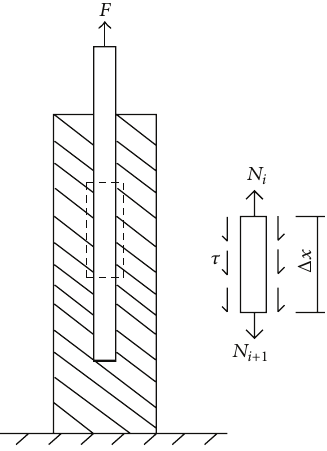
Figure 2: Interfacial mechanics model between bolts and bonding